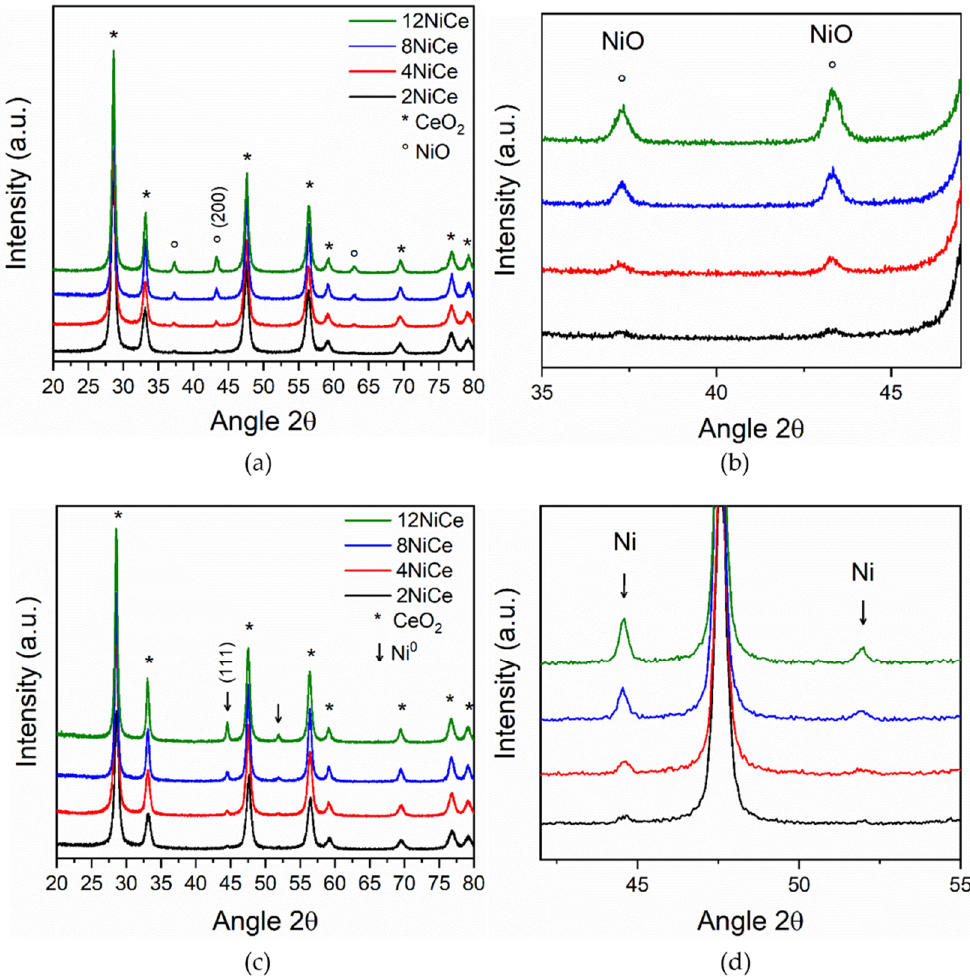
Figure 4. XRD diffraction peaks of samples: ( a , b ) calcined and ( c , d ) reduced: ( a , c ) full range; ( b , d ) enlarged .